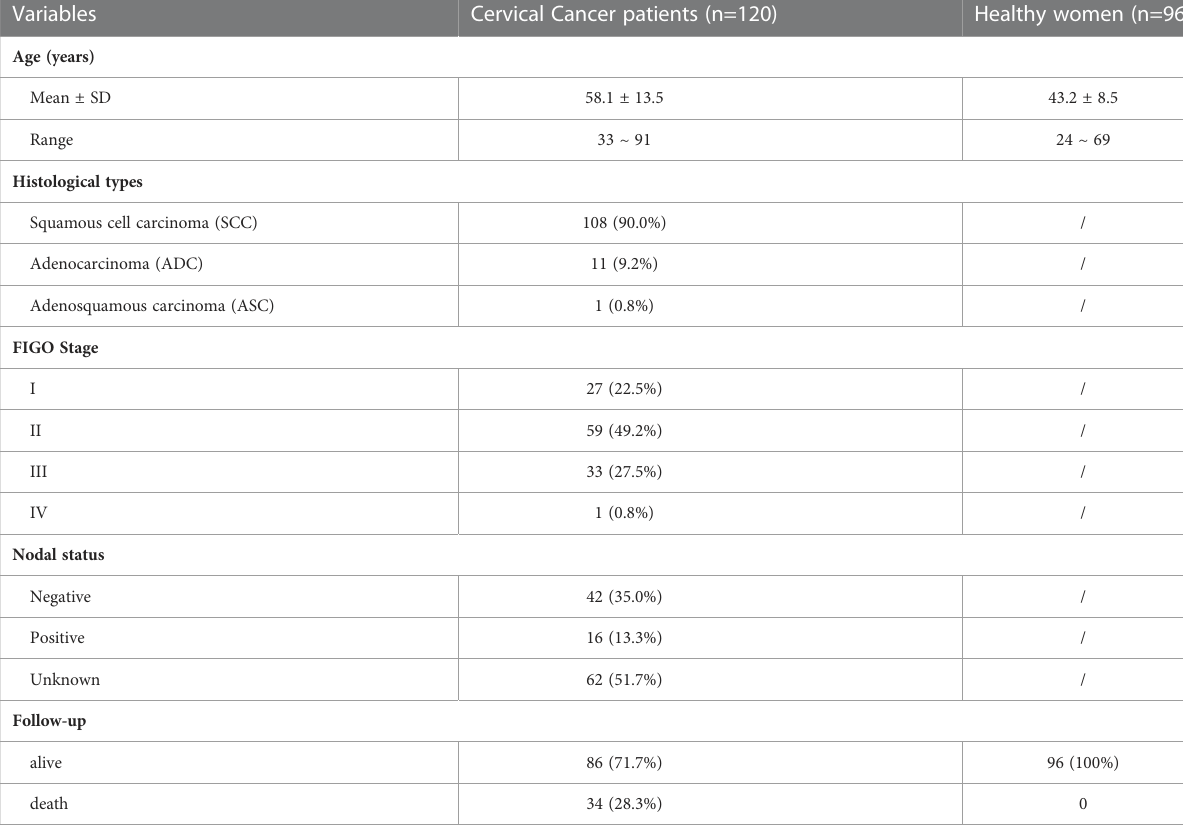
TABLE 1 Study Population Characteristics.